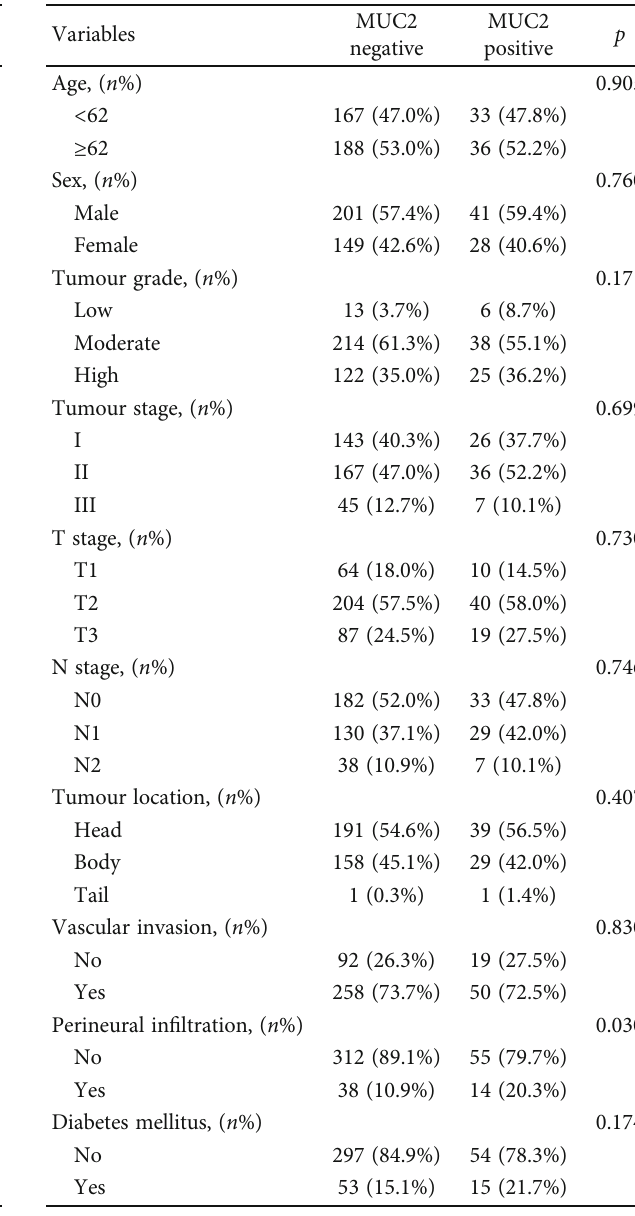
Table 2: Clinicopathological characteristics of FUSCC PDAC patients strati fi ed by MUC2